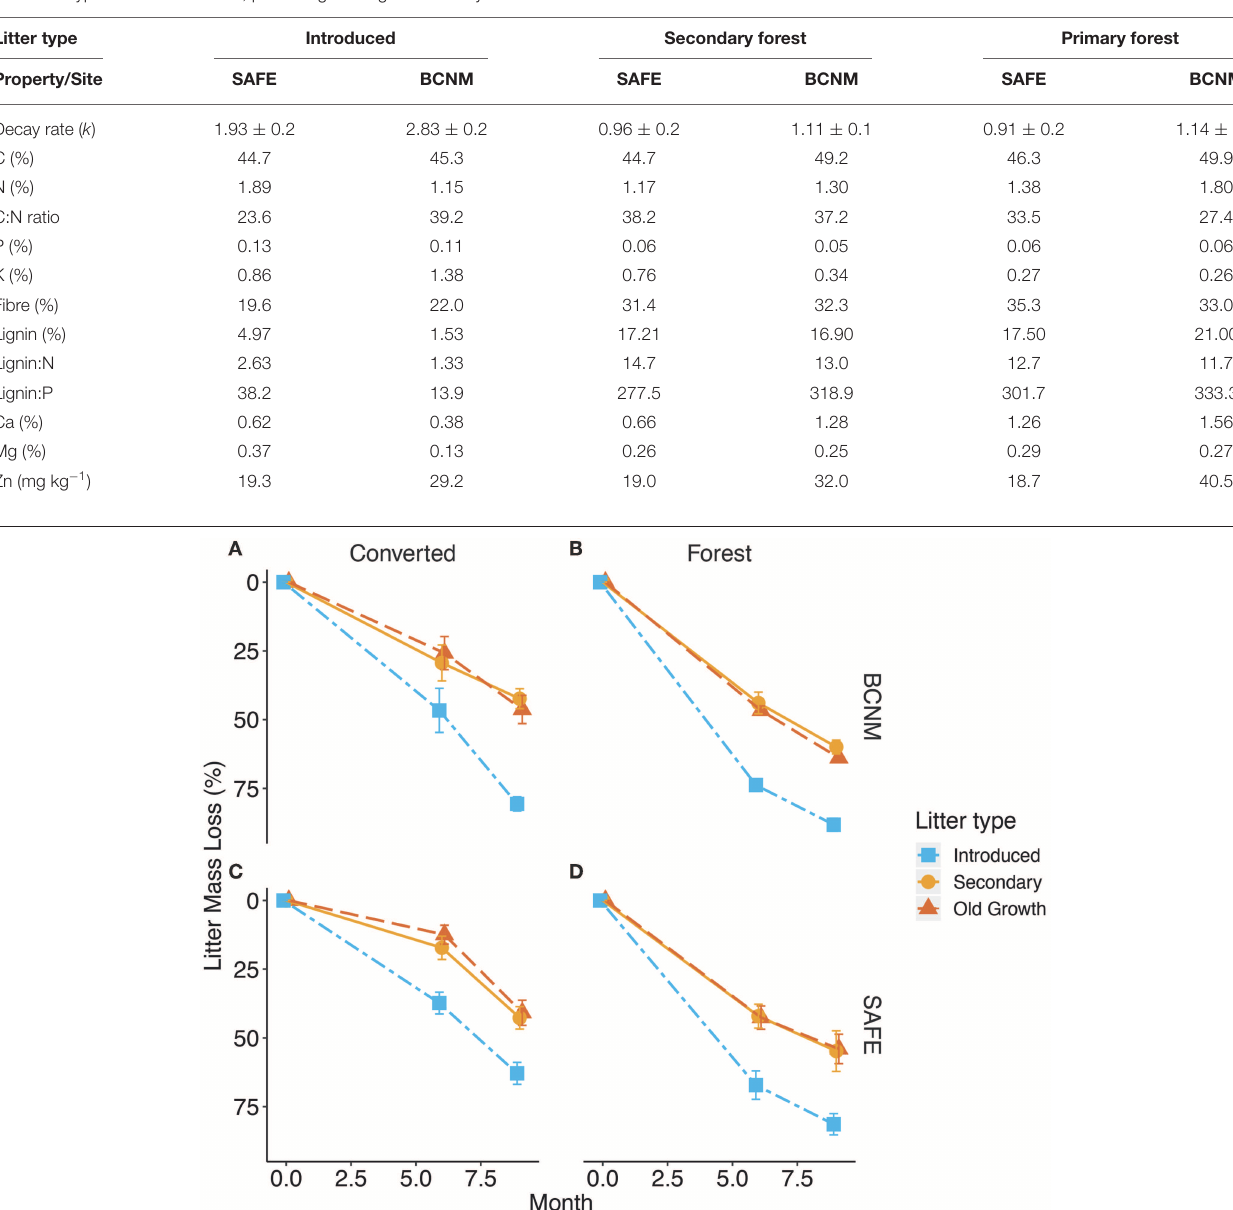
TABLE 3 | Characteristics of leaf litter from forest habitats or introduced species used in parallel litter decomposition experiments at SAFE in Malaysian Borneo and BCNM in Panama, showing litter carbon (C) and nitrogen (N) content, carbon to nitrogen ratio (C:N), phosphorus (P), potassium (K), calcium (Ca), magnesium (Mg), total fibre and lignin content, and lignin to nitrogen ratio (lignin:N); chemical analyses were conducted on composite litter samples and mean decay rates were calculated for each litter type across all habitats; percentages are given on a dry mass basis. Litter type